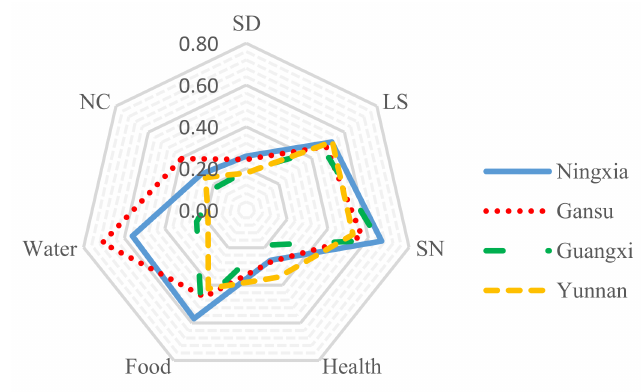
Figure 3. Vulnerability spider diagram of the main indicators of the Household Livelihood Vulnera- bility Index (HLVI) for Ningxia, Gansu, Guangxi, and Yunnan, China.